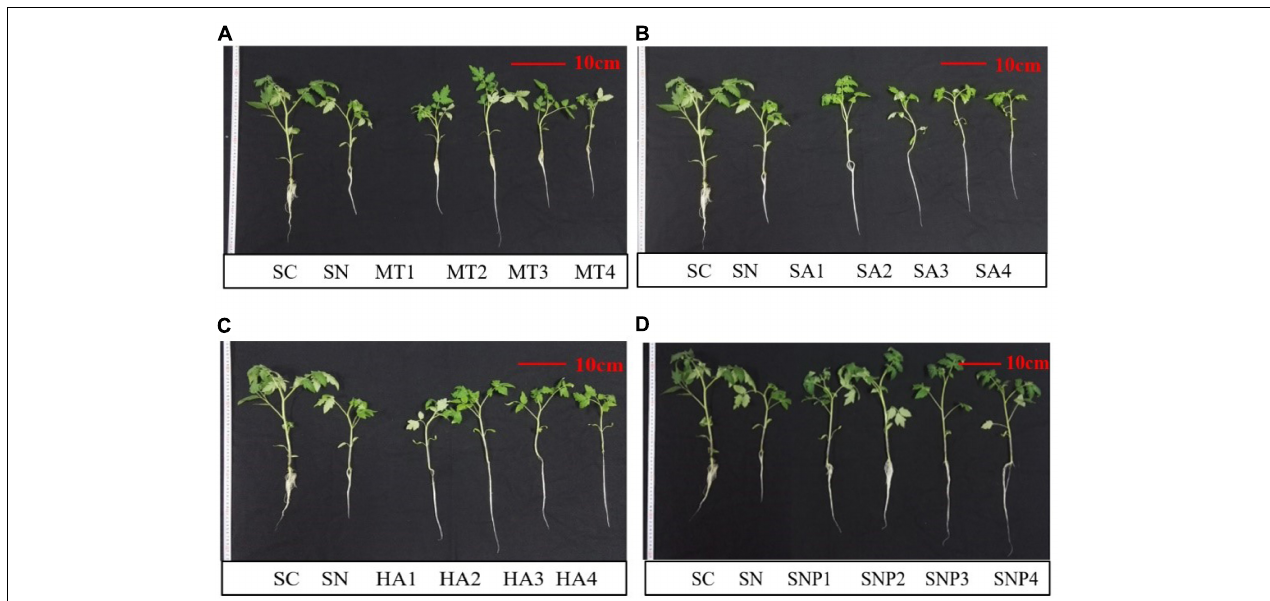
FIGURE 3 | Effects of different concentrations of (A) MT, (B) SA, (C) HA, and (D) SNP on tomato growth under high-nitrate stress. SC, control; SN, high-nitrate stress treatment; MT, melatonin; SA, salicylic acid; HA, humic acid; SNP, sodium nitroprusside; MT1–4 represented SN + 25 µ mol L − 1 , 50 µ mol L − 1 , 100 µ mol L − 1 , 200 µ mol L − 1 MT; SA1–4 represented SN + 25 µ mol L − 1 , 50 µ mol L − 1 , 100 µ mol L − 1 , 200 µ mol L − 1 SA; HA1–4 represented SN + 25 mg L − 1 , 50 mg L − 1 , 100 mg L − 1 , 200 mg L − 1 HA; SNP1–4 represented SN + 25 µ mol L − 1 , 50 µ mol L − 1 , 100 µ mol L − 1 , 200 µ mol L − 1 SNP. To allow for direct comparison, the same plants for SC and SN were used in the four